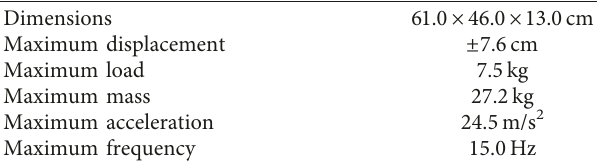
Table 3: Characteristics of the Shake Table II Quanser